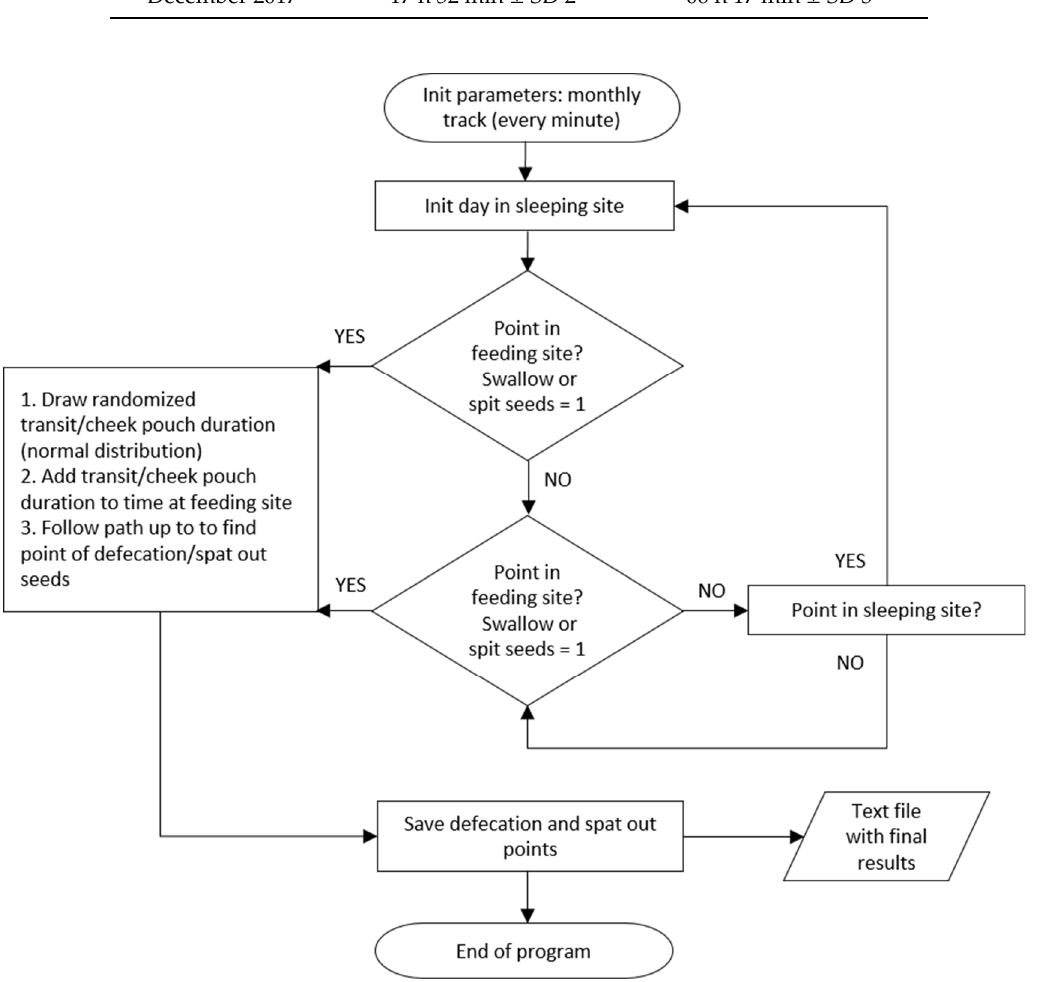
Figure A1. Model of seed transfer to estimate seed shadows based on northern pigtailed macaques’ movement pattern and resource use in Sakaerat.